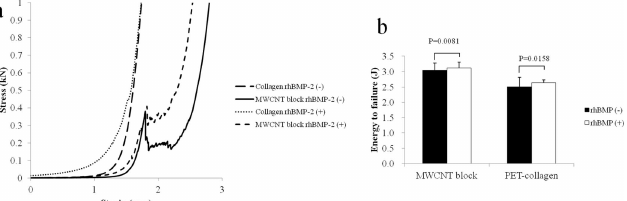
Fig 8. Compression test of ectopic bones formed around MWCNT blocks. Graph shows (a) the energy to failure and (b) the Stress-Strain curves of ectopic bones formed aroundthe MWCNT blocks and PET- reinforcedcollagensheets in the presenseand absenceof